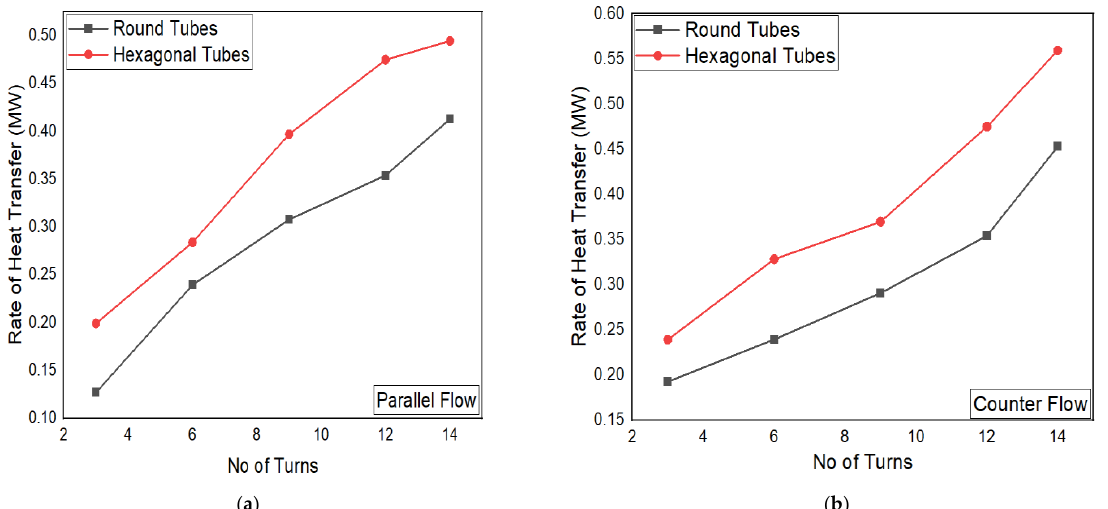
Figure 6. ( a ) Variation of the heat transfer rate due to the number of turns of the tube in ( a ) parallel flow; ( b ) in counter flow.